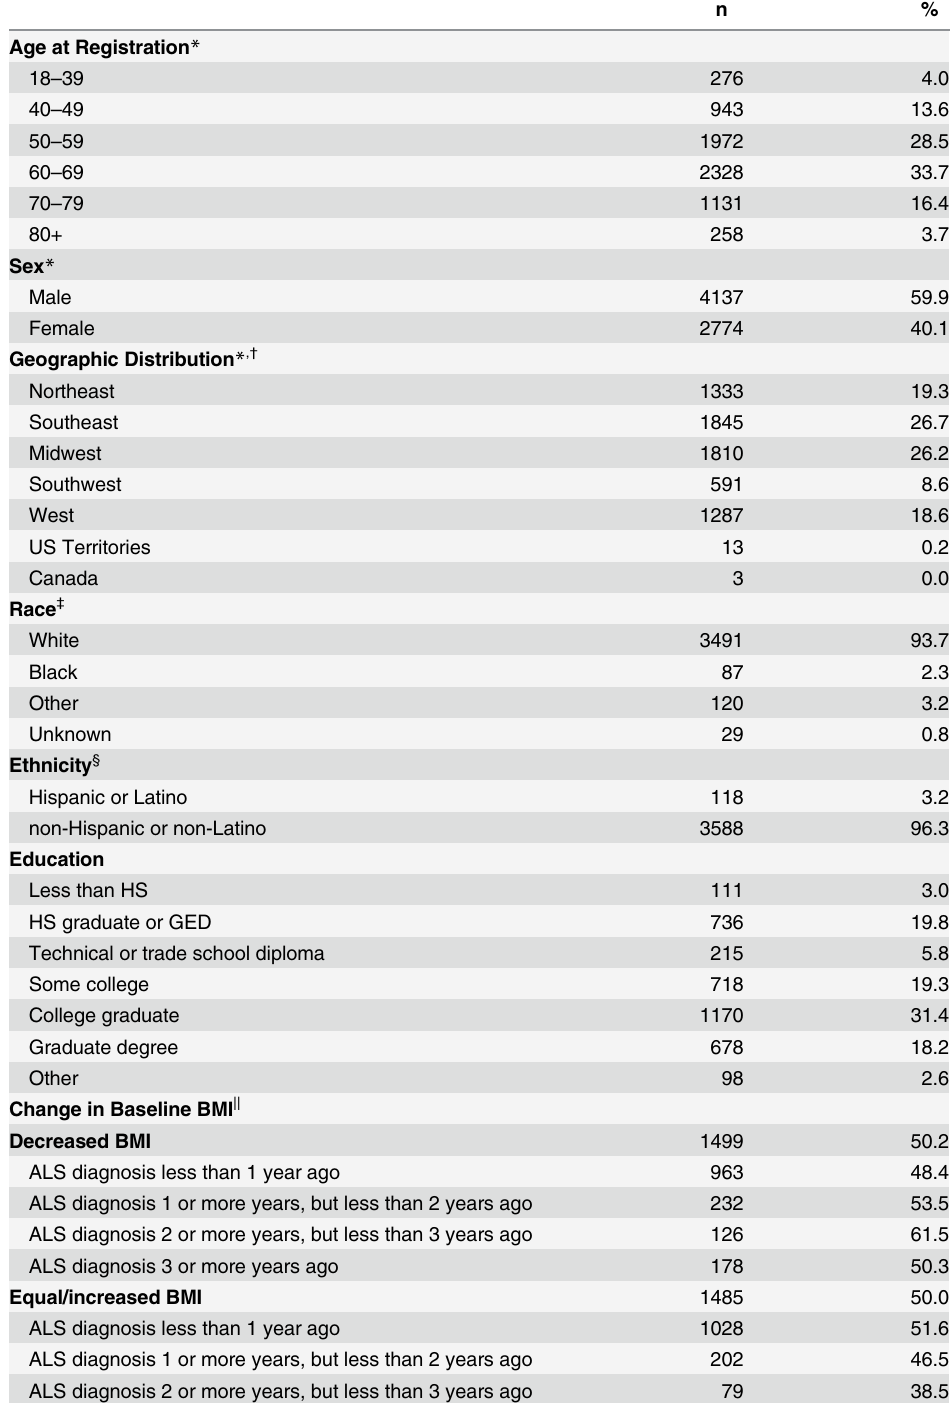
Table 1. Demographic Characteristics among Adults with ALS (October 19, 2010 – December 31,